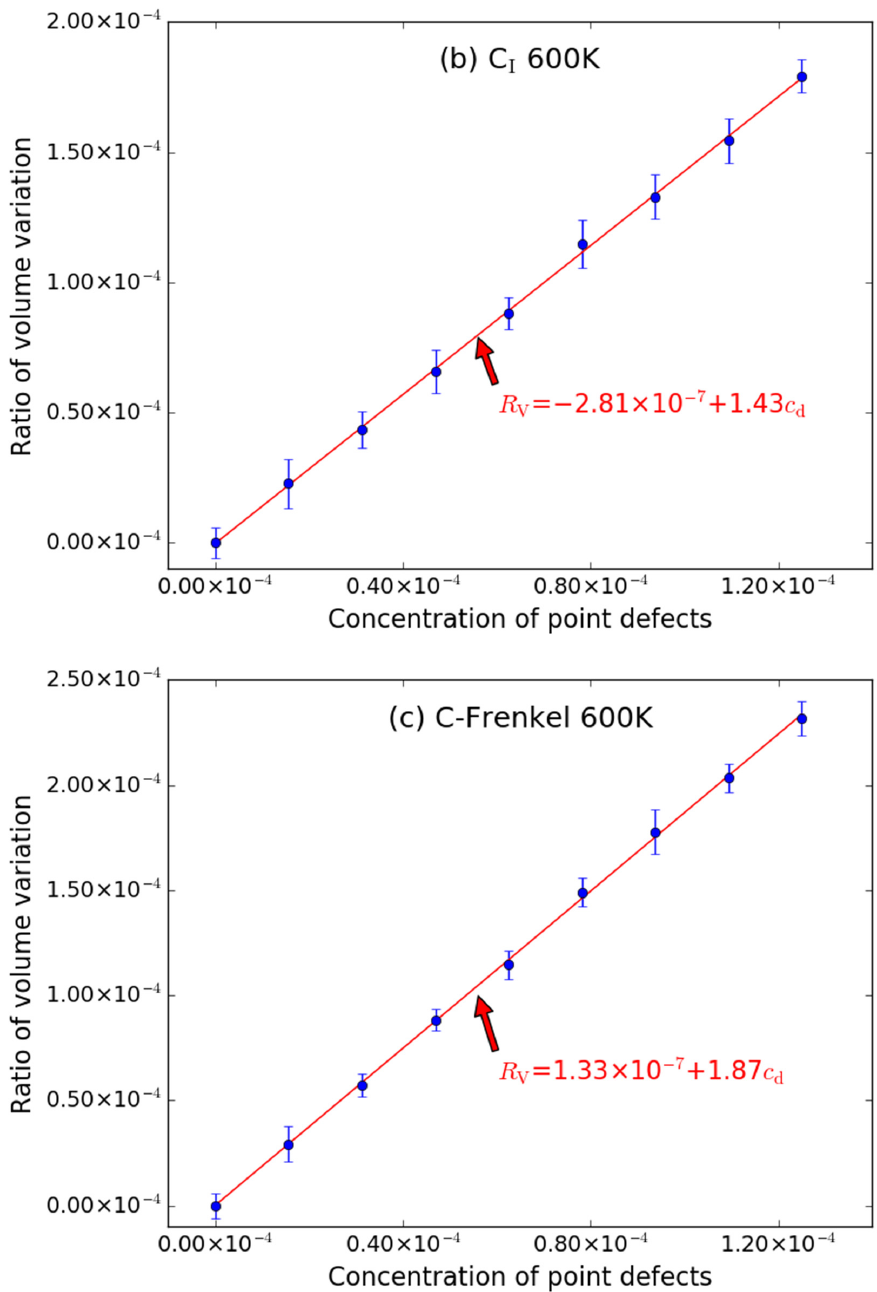
Figure 2. The ratio volume variation ( R V ) of supercell caused by C-type point defects (( a ) C V , ( b ) C I and ( c ) C-Frenkel pair) as function of concentration ( c d ) of point defects at 600 K. The error bars denote the standard deviations of the values. The size of supercell in MD simulation is 20 a × 20 a × 20 a .